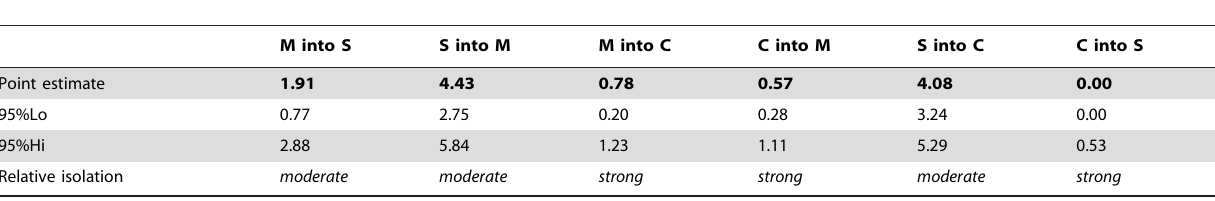
Table 5. Population migration rates (2 Ne M) estimated from IMa2.